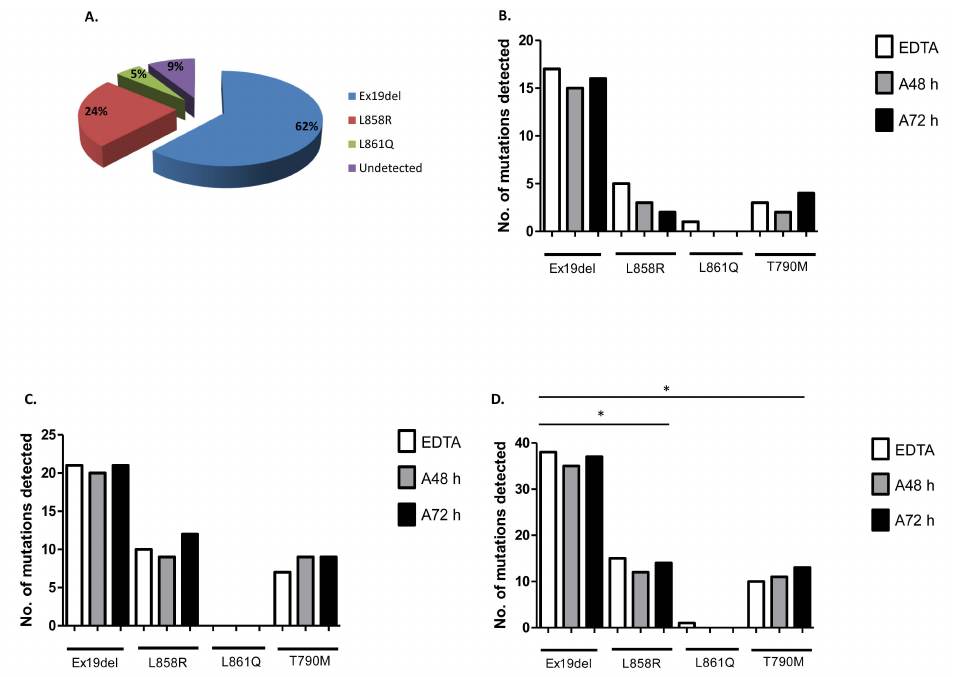
Figure 2. Plasma genotyping of EGFR mutations using the cobas ® EGFR mutation v2 test. Plasma genotyping of EGFR mutations using cfDNA from liquid biopsy was carried out using the cobas ® EGFR mutation v2 test. EGFR mutations identified included exon 19 deletions, L858R point mutations and L861Q mutations in exon 21 ( A ). A comparator analysis of EGFR sensitizing and resistance mutations ( EGFR exon 20 p.T790M) in standard EDTA and CE-IVD cell-free DNA blood collection tubes (Roche) was examined in cohort 1 ( B ) and cohort 2 ( C ). EGFR mutations across both cohorts combined are also shown ( D ). Statistical analysis was performed using a two-way ANOVA with Bonferroni post-hoc analysis (* p <